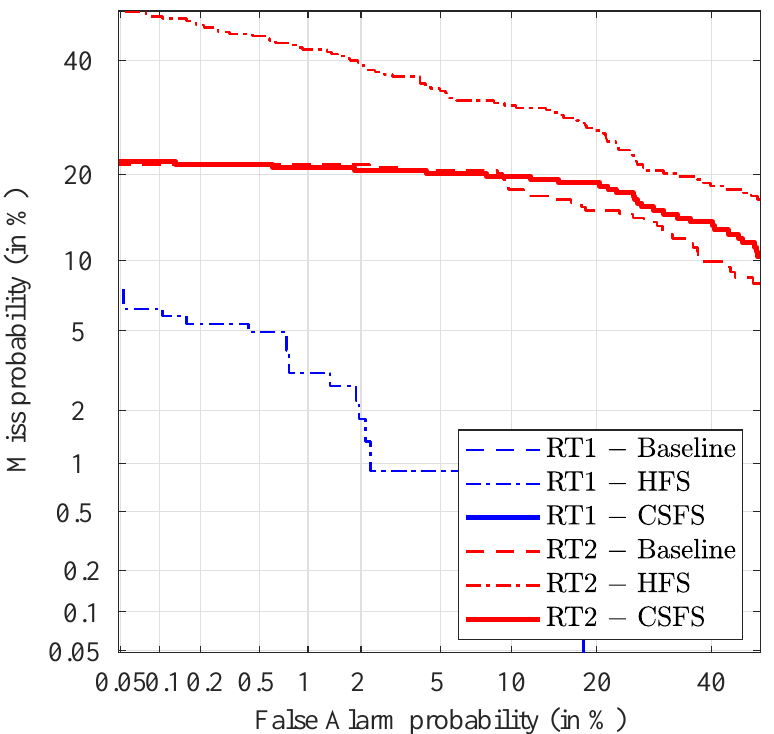
Figure 8. DET plots for non-stabilized